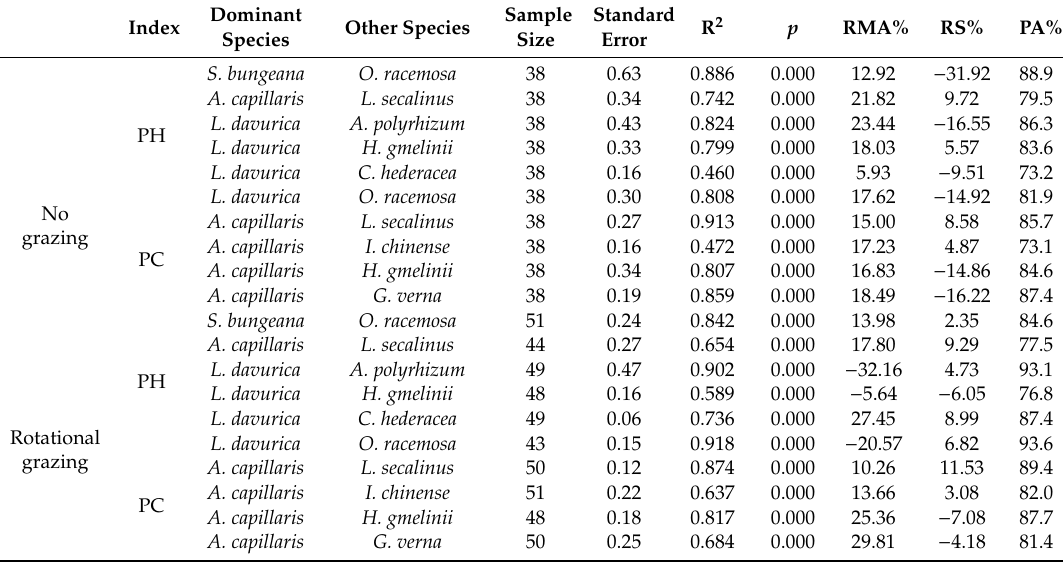
Table 5. Accuracy test of predictive equations under two managements of